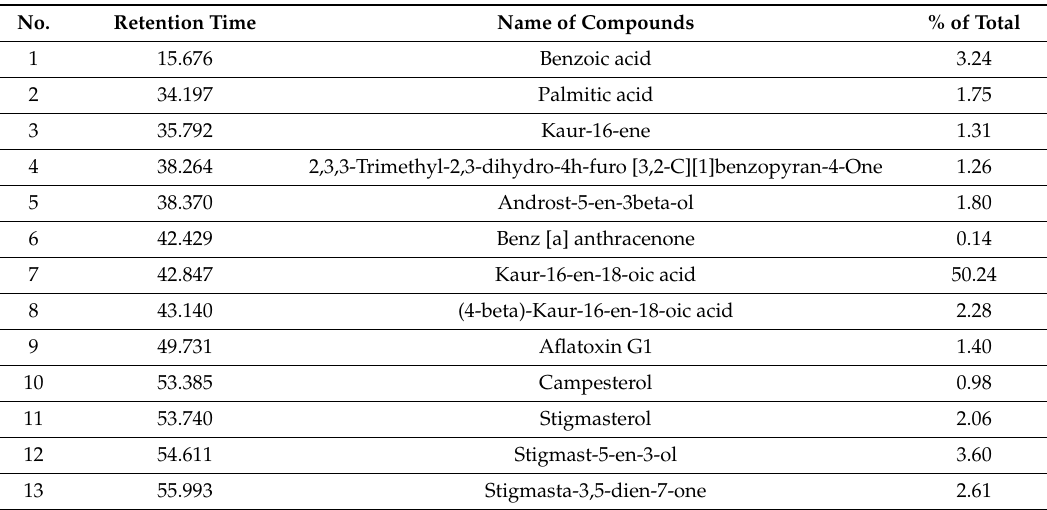
Table 3. Retention time, name, and percentage of the total of the enabling identification compounds from CEA.